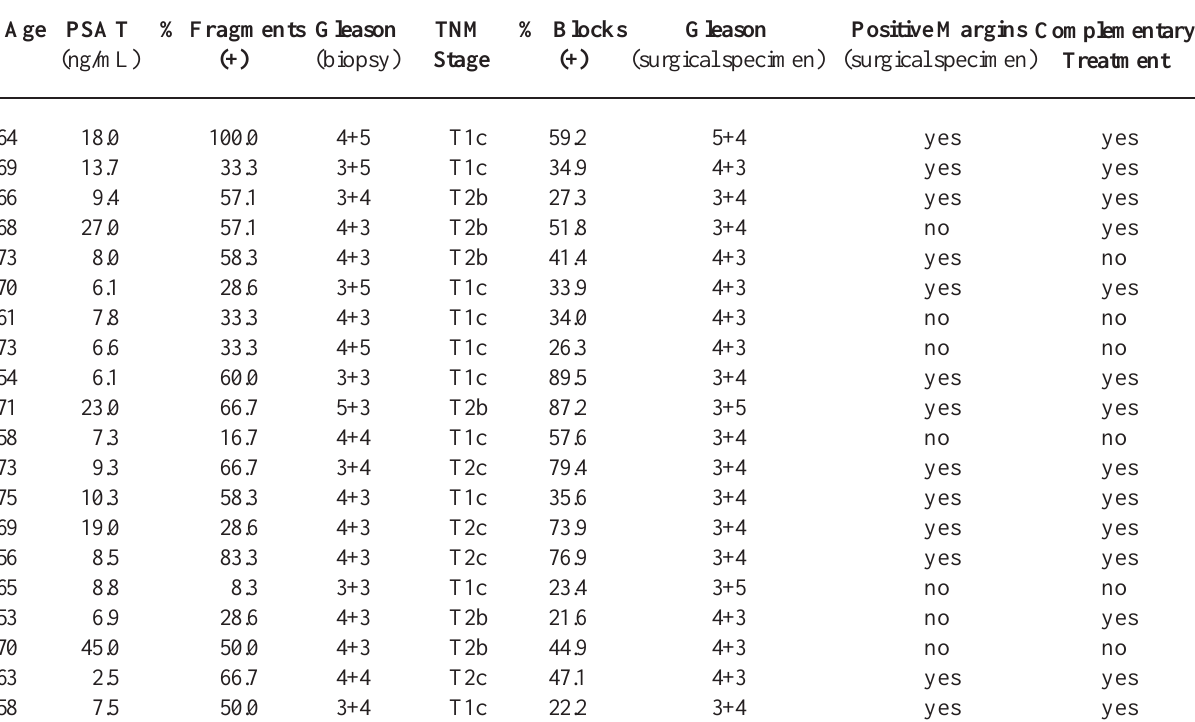
Table 2 – Clinical and morphologic pre and postoperative data of the patients submitted to radical prostatectomy and classified as